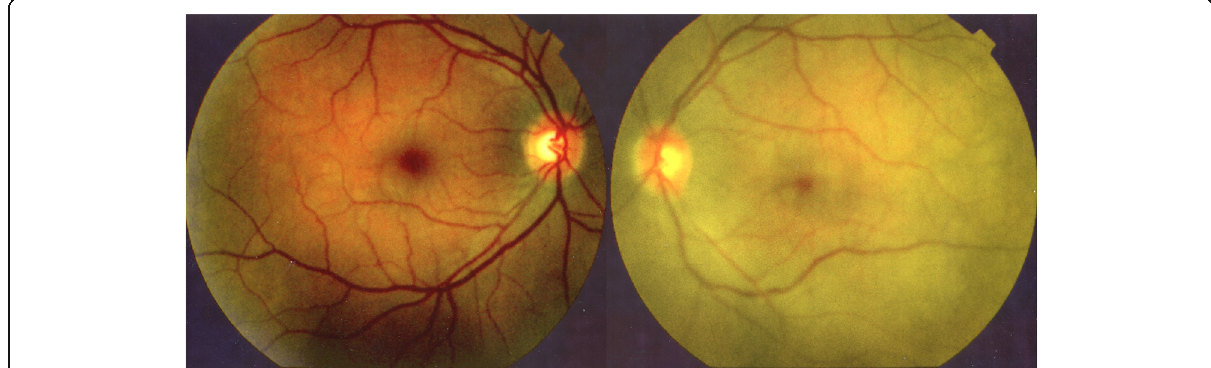
Fig. 1 Case of VKH at presentation. Fundus picture showing yellow discoloration of the left eye due to choroidal infiltration while the right fundus is